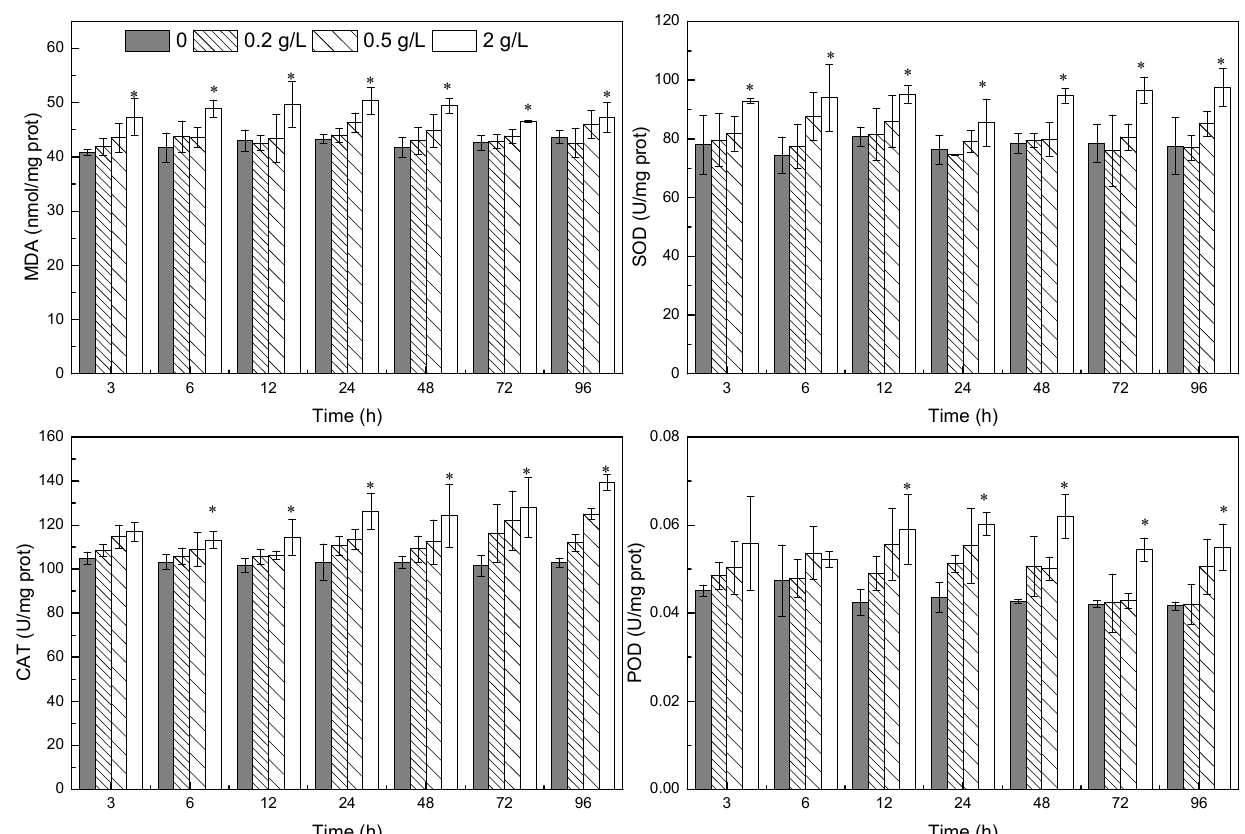
Figure 4. Changes in the antioxidant system parameters of newly hatched larvae over time, mean ± SD; ANOVA, Tukey; * significant difference compared with control at each time point at p < 0.05. Table 2. Summary of 2-way analysis of variance testing the effects of time and modified clay on MDA, SOD, CAT, and POD in marine medaka.